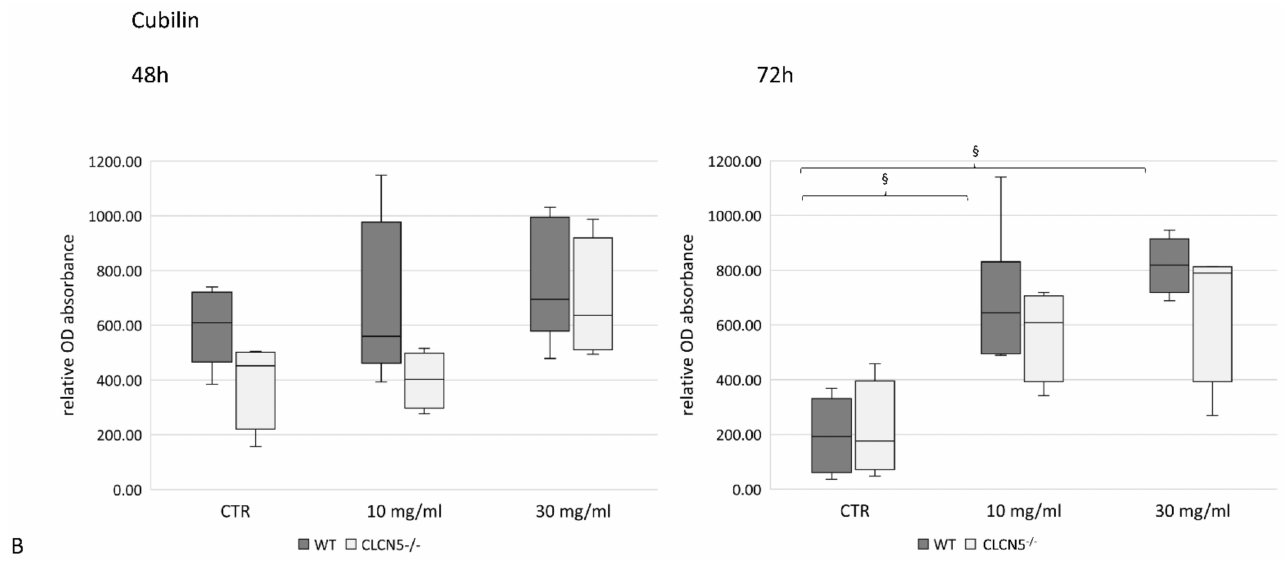
Figure 11. Cubilin expression in WT and CLCN5 − / − clones following albumin treatment (10 mg/mL and 30 mg/mL) at different time points (24, 48, and 72 h). Boxplots show medians and interquartile ranges of ( A ) relative mRNA, as determined by qRT-PCR, and ( B ) protein expression, as determined by ICW. p -values were obtained with the Mann–Whitney U test. * p < 0.001; § p < 0.005; # p < 0.01; $ p < 0.05. Results are from two independent experiments performed in triplicate (qRT-PCR) and in quadruplicate (ICW). Abbreviations: nRQ: normalized relative quantity; OD, optical density.